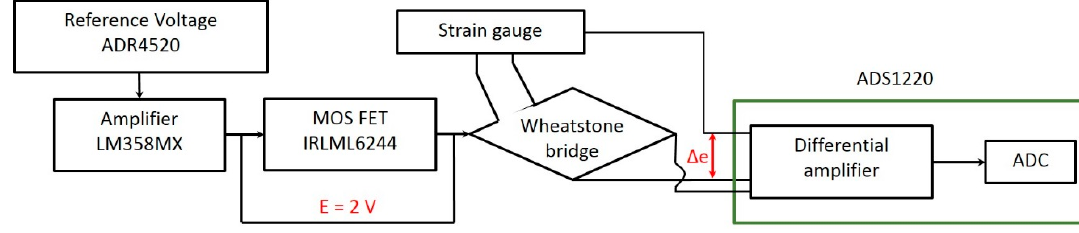
Figure 7. Strain gauge circuit block diagram.